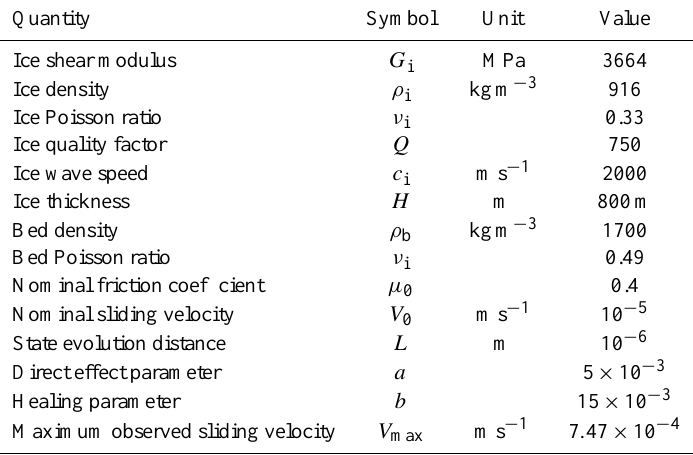
Table 1. Table of material properties that are held fixed.